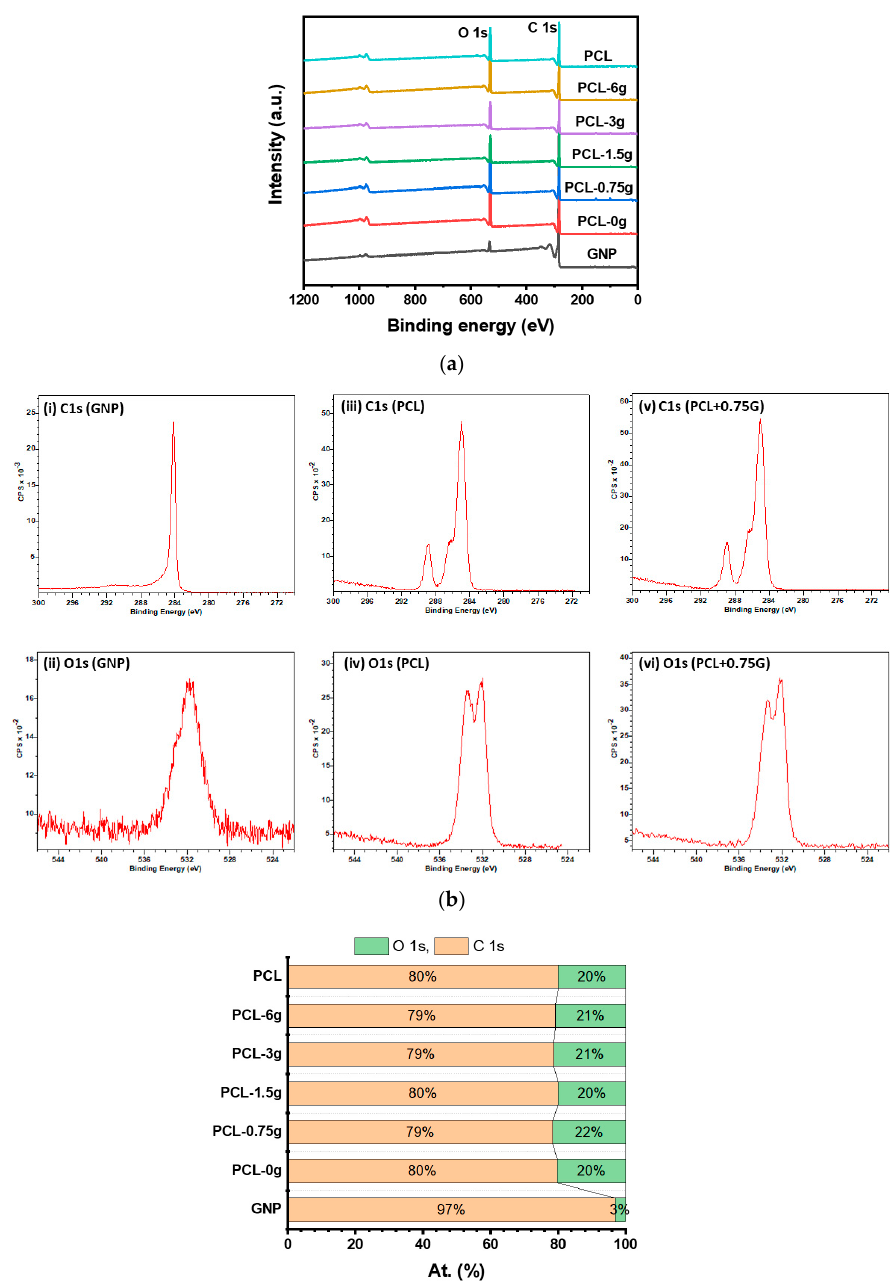
Figure 4. ( a ) Wide Energy Survey Scans (WESS) for the as-received G nanoplatelets (GNP), 3D-fabricated scaffolds (PCL, PCL+0.75G, PCL+1.5G, PCL+3G, and PCL+6G) and as-received PCL (in ascending order). X-Ray spectra were collected using monochromated Al K α X-rays (h ѵ = 1486.6 eV), operating at 10 mA and 15 kV, with WESS obtained from three random locations on each scaffold at a 160 eV pass energy. A charge neutraliser system was employed, operating at filament current